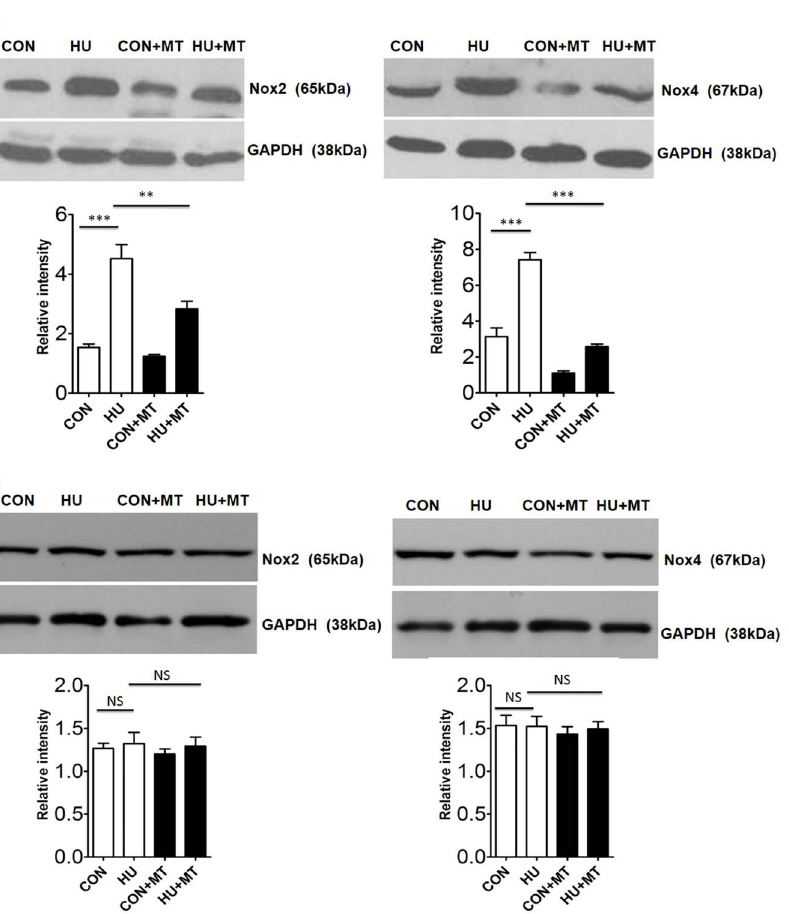
Figure 3. The protein expression of Nox2 and Nox4 in rat cerebral (A) and mesenteric (B) arteries. The protein abundance of Nox2 and Nox4 was analyzed by western blot. CON, control; HU, hindlimb unweighting; CON + MT, mitoTEMPO-treated control; HU + MT, mitoTEMPO-treated HU. Values are mean 6 SEM. ** P , 0.01 for HU vs. control, *** P , 0.001 for HU vs . HU + MT.